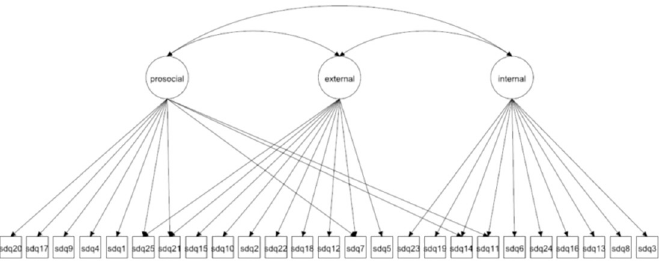
Fig 2. 3-factor model with cross-loadings (Model 2a).